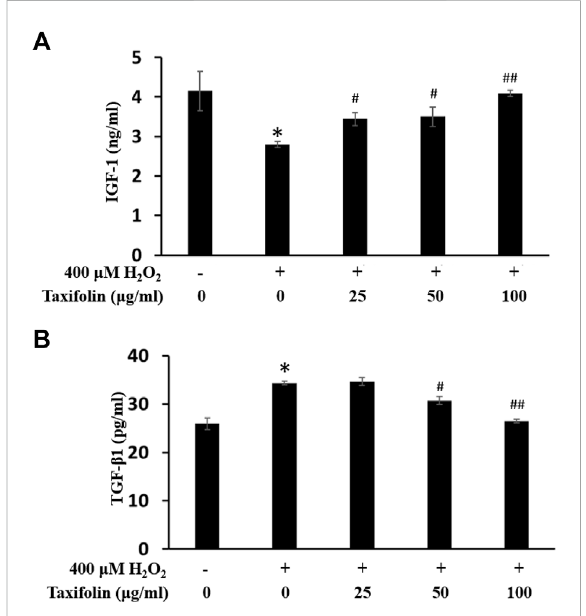
Recovery effects of taxifolin on oxidative stress-induced (A) IGF-1 formation and (B) TGF- β 1 production. Cells were pre- incubated with indicated concentration of taxifolin ( μ g/mL, w/v) and treated with hydrogen peroxide for 12 h. IGF-1 production as measured as described in Materials and methods . Data are expressed as the mean ± SD. * p < 0.001 vs. non-treated group. # p < 0.05 and ## p < 0.005 vs. control group (hydrogen peroxide treated only). TGF- β 1 production was measured as described in Materials and methods . Data are expressed as the mean ± SD. * p < 0.01 vs. non-treated group. # p < 0.05 and ## p < 0.01 vs. control group (hydrogen peroxide treated